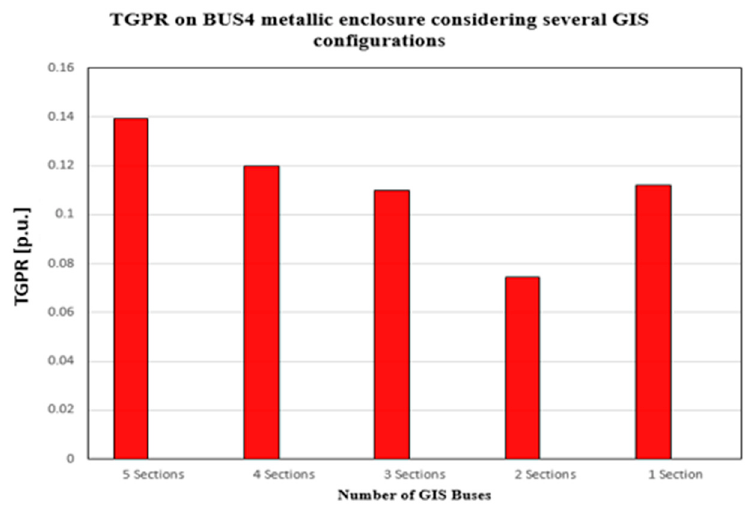
Figure 10. Comparison between TGPR computed considering five GIS configurations.